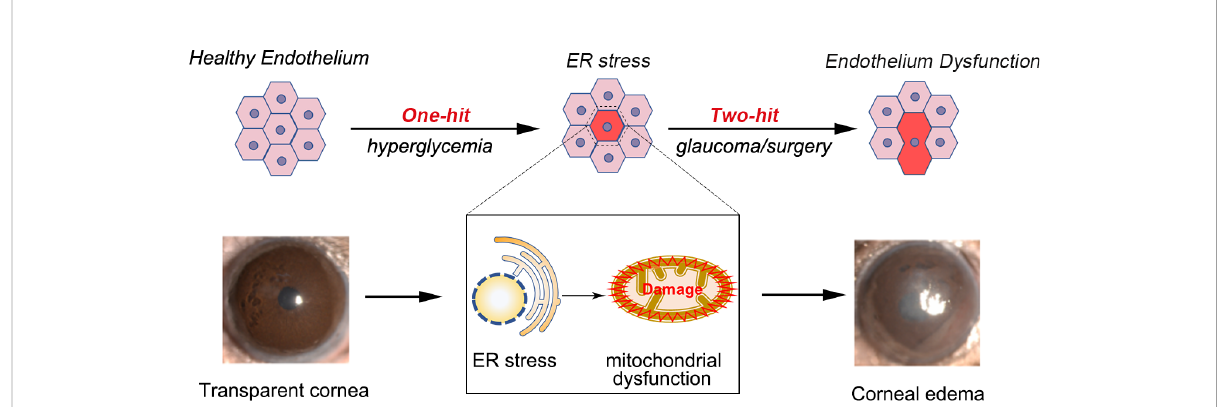
FIGURE 4 Proposed mechanism of endothelium dysfunction in the diabetic cornea. Endothelial cells from diabetic mice exhibit high levels of ER stress and ER stress appears before morphological changes of the endothelium. Activation of ER stress can promote corneal endothelial dysfunction by triggering mitochondrial dysfunction. Acute injuries, such as glaucoma, can lead to corneal edema and endothelial cell